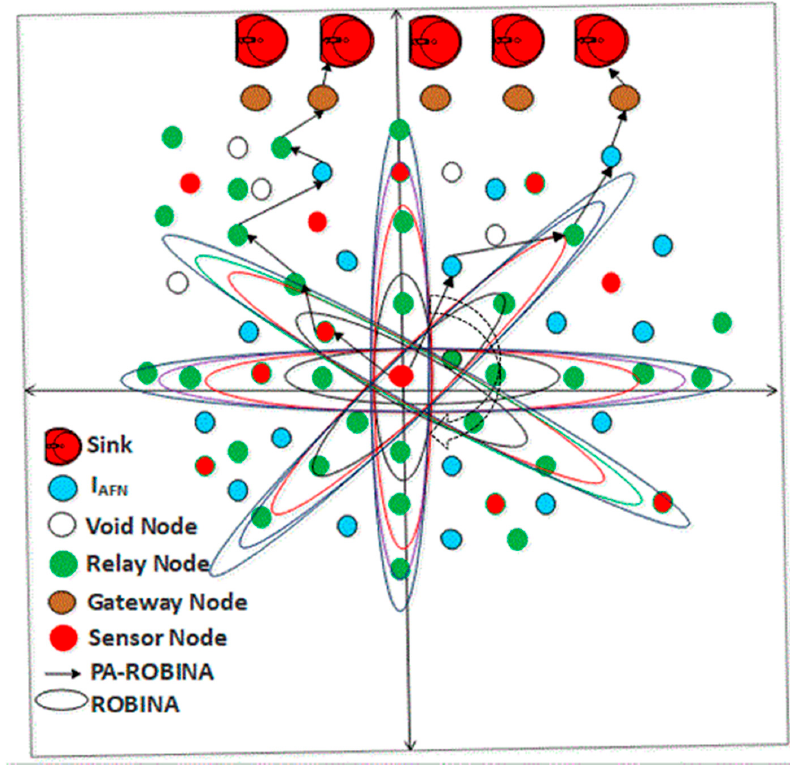
Figure 4. The woring of PA-ROBINA in acoustic scenario.